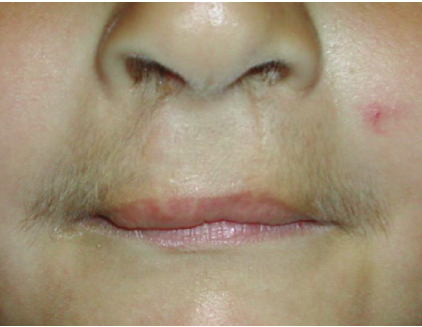
Figure 1: Upper lip of the patient at age 3 6/12 yrs. Note the moustache with dark pigmented hair over the upper lip and the scars of the cleft lip operations.